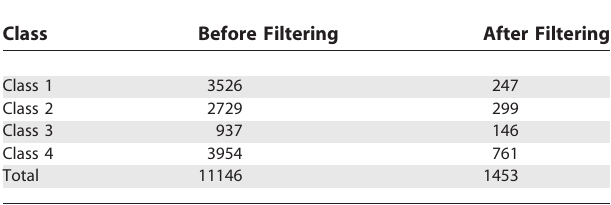
Table 1. Number of Human–Mouse Sequence Pairs prior to and following Mutual-Best-Hit Filtering